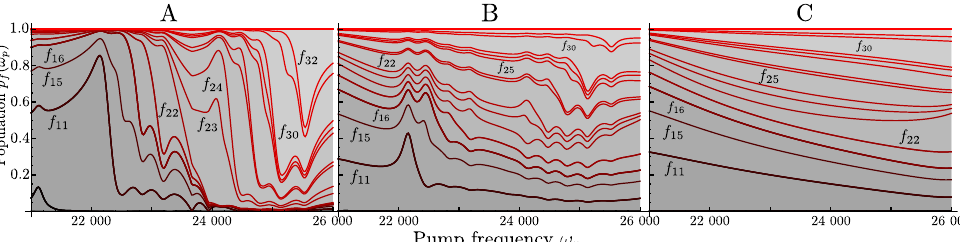
Fig. 2. The distribution of states in the double-exciton manifold f 1 ... f 41 created by entangled photons (A), chirped pulses (B), and stochastic light (C) are plotted vs. the pump frequency ω p . The power spectrum cor- responding to the chosen parameters is identical for all beams and shown in Fig.